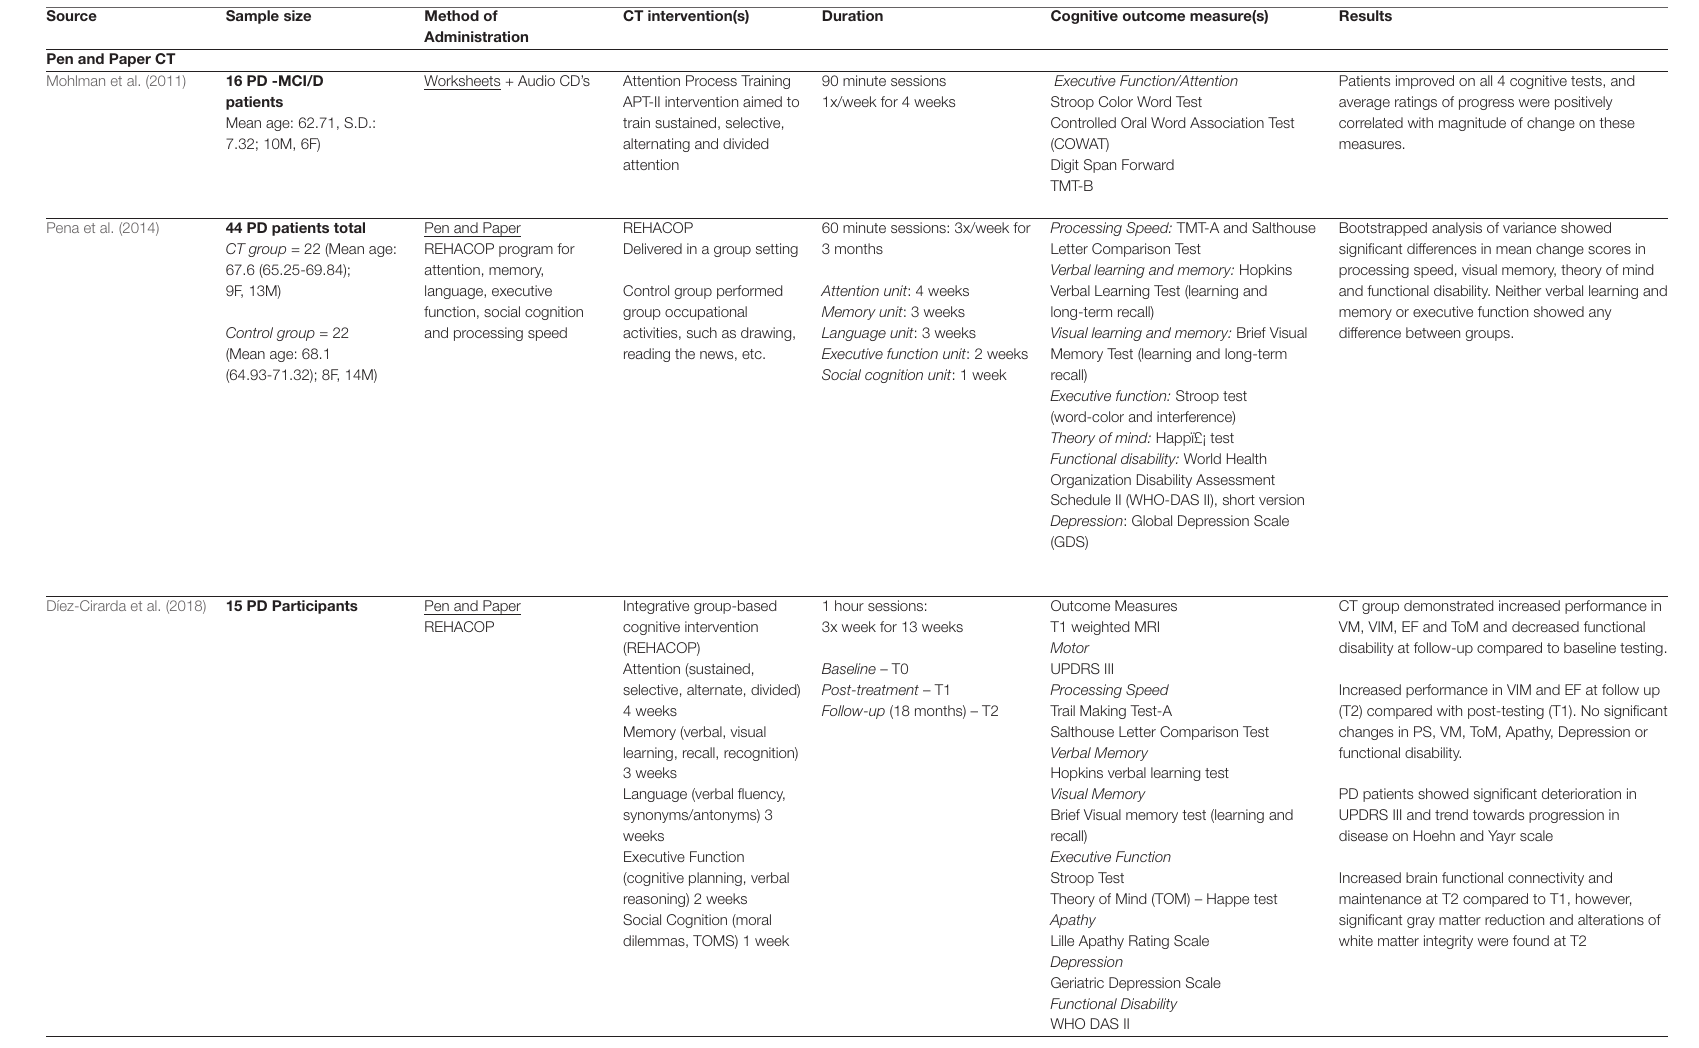
TABLE 1 | Study methodology details of Cognitive training in Parkinson’s disease.